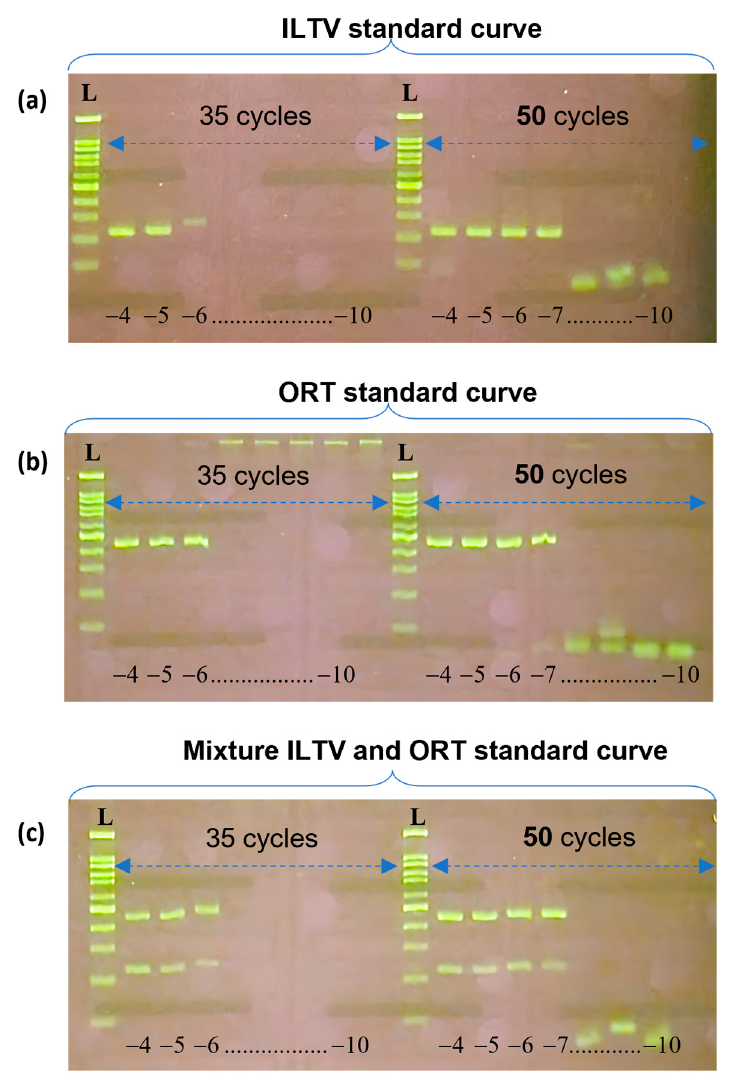
Figure 4. Agarose gel electrophoresis showing the limit of detection of multiplex PCR. ( a – c ) Limit of detection of multiplex PCR was determined after 35 and 50 thermal cycles. To save reagents, the starting dilution used was from 10 − 4 ( − 4) to 10 − 10 ( − 10), with the copy number equivalent to 3.92 × 10 6 for ILTV and 2.18 × 10 6 for ORT. On hundred bp DNA ladder (L); the lowest band was one hundred bp, and the brightest band was fi ve hundred bp.